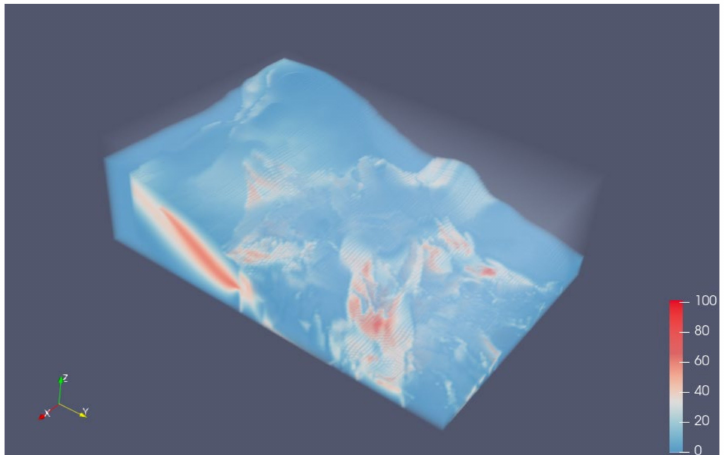
Figure 10. Rendering images of geological hazard analysis result model. The red areas in the figure indicate a high probability of hazard in our analysis method, further analysis in these areas were